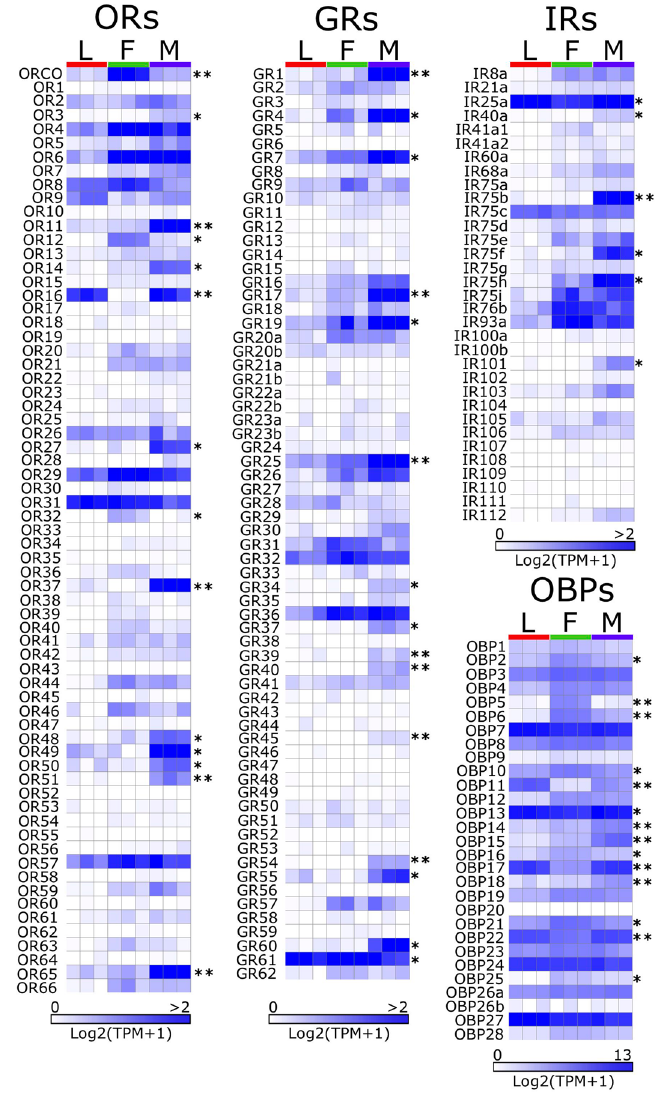
Figure 6. In silico mRNA abundance of chemosensation-related genes. Heat maps represent the abundance of mRNA reads for odorant receptors (ORs), gustatory receptors (GRs), ionotropic receptors (IRs) and odorant- binding proteins (OBPs) in RNA-seq libraries from females (F), males (M) and larvae (L) as estimated by Kallisto. Read abundance is expressed as Log2(TPM + 1). Black asterisks represent chemosensory genes with significant differences at mRNA abundance between females and males as calculated by Kallisto-Sleuth pipeline (False Discovery Rate [FDR] adjusted p -value: * < 0.01; ** <